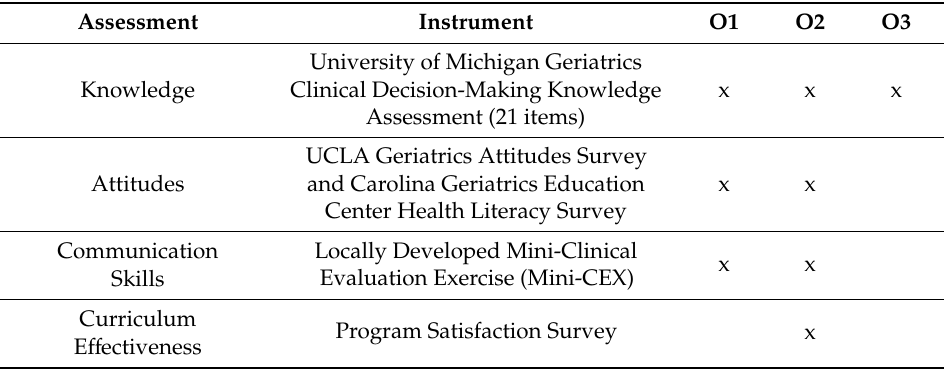
Table 2. Learner